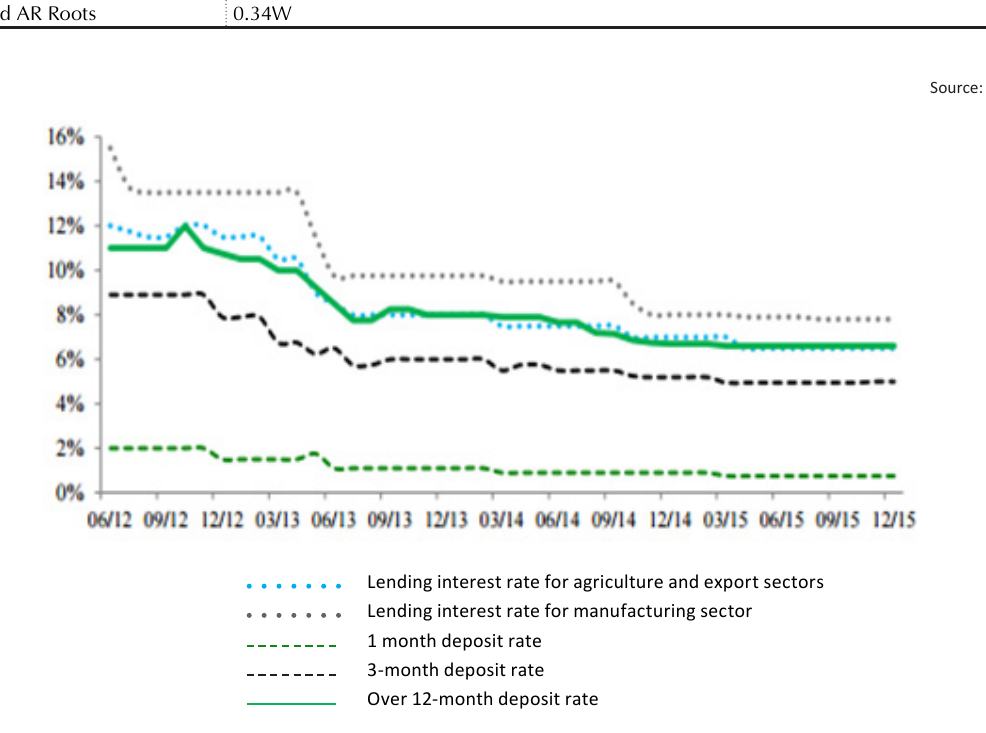
Figure B1. Deposit and lending rates of the commercial banks in Vietnam from June 2012 to December 2015